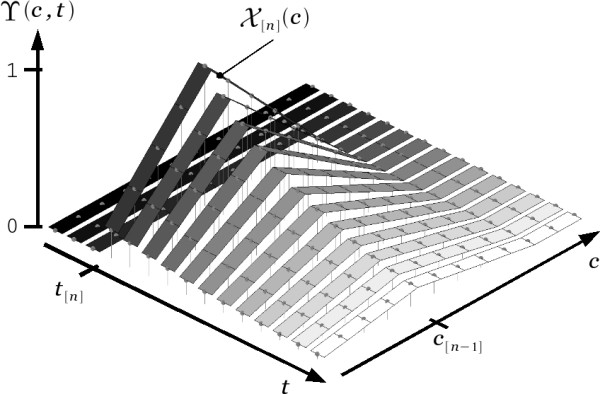
A discrete time sequence of the viscoelastic deformation of the 1-dimensional domain C depicted by function ϒ(c, t). The deformation X[n](c), occurring at time t[n], experiences a steady decay over time.